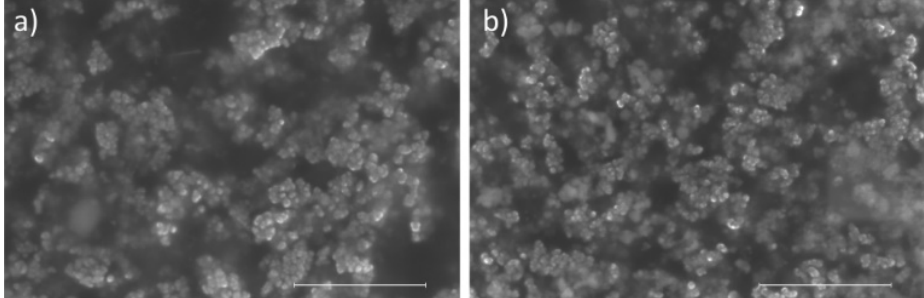
Figure 1. Scanning electron microscopy (SEM) images of MIPs prepared using: ( a ) AHAMTES ‐ based solid phase, ( b ) IPTMS ‐ based solid phase. Scale bar = 2 μ m.